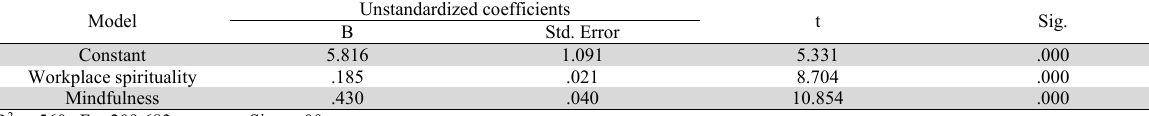
Relationship between Workplace Spirituality, Mindfulness and Mental wellbeing